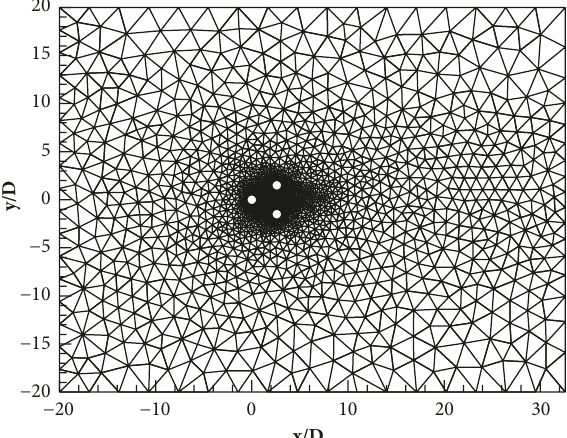
Figure 12: Computational grid for flow around three circular cylinders with 𝑆/𝐷 = 4.0